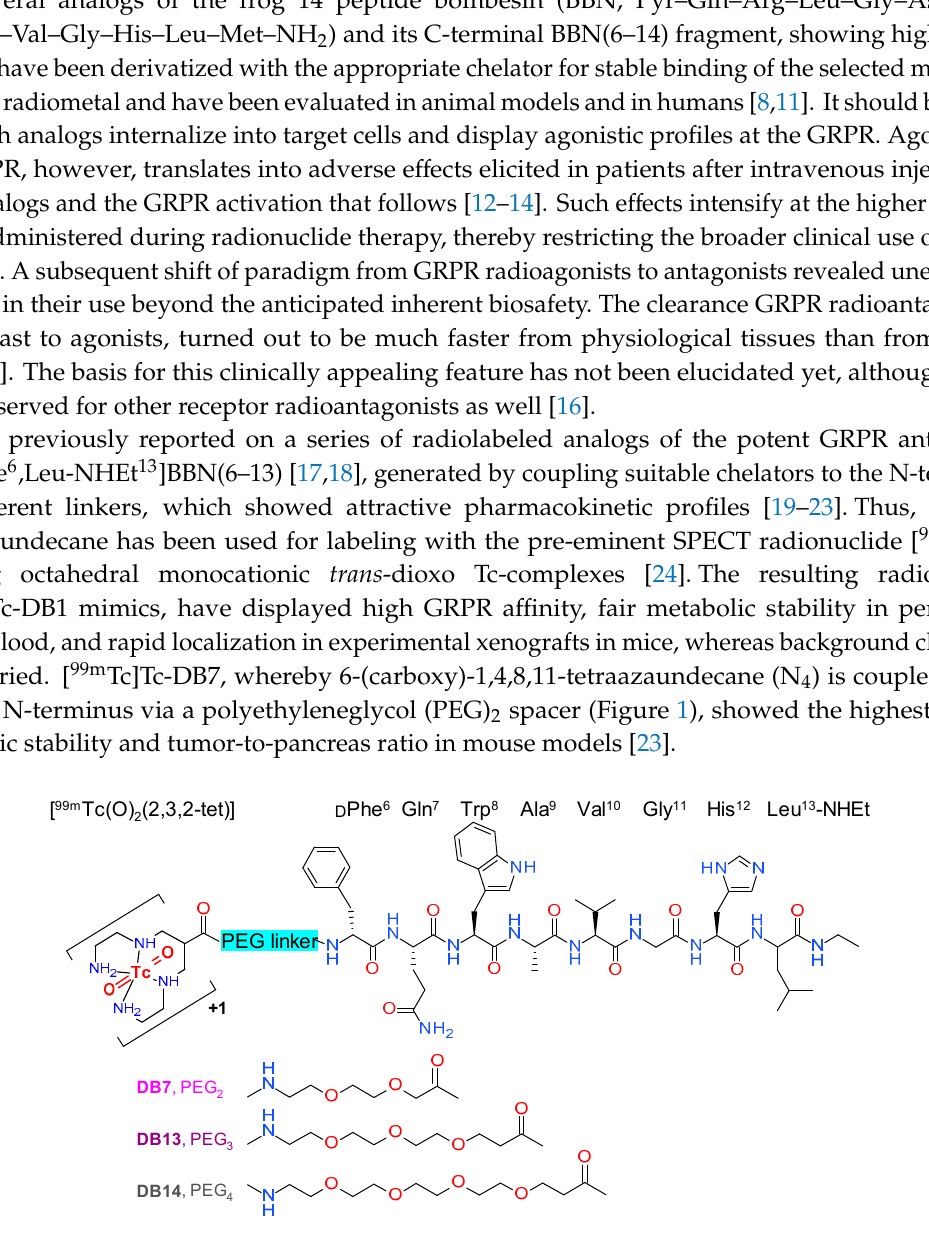
Figure 1. Chemical structure of [ 99m Tc]Tc-DB7 (PEG 2 ), [ 99m Tc]Tc-DB13 (PEG 3 ), and [ 99m Tc]Tc-DB14 (PEG 4 ).